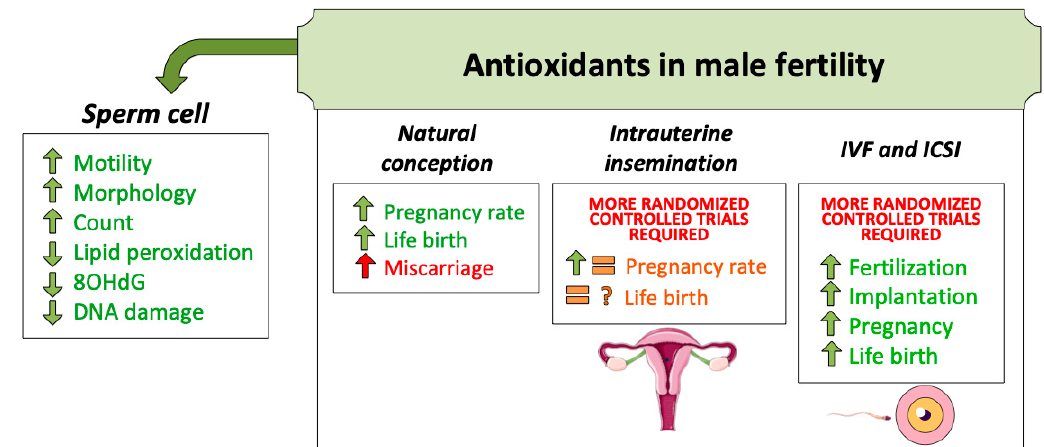
Figure2. Antioxidanttreatmentsformalefertilityhavebeenusedfordecades. Figure 2. Antioxidant treatments for male fertility have been used for decades. Until the present moment, evidence supports its use to achieve better sperm quality. This, in turn, increases natural conception success. Regarding assisted reproduction techniques (ART), more randomized and controlled trials are necessary to confirm the benefit of oral antioxidant intake.